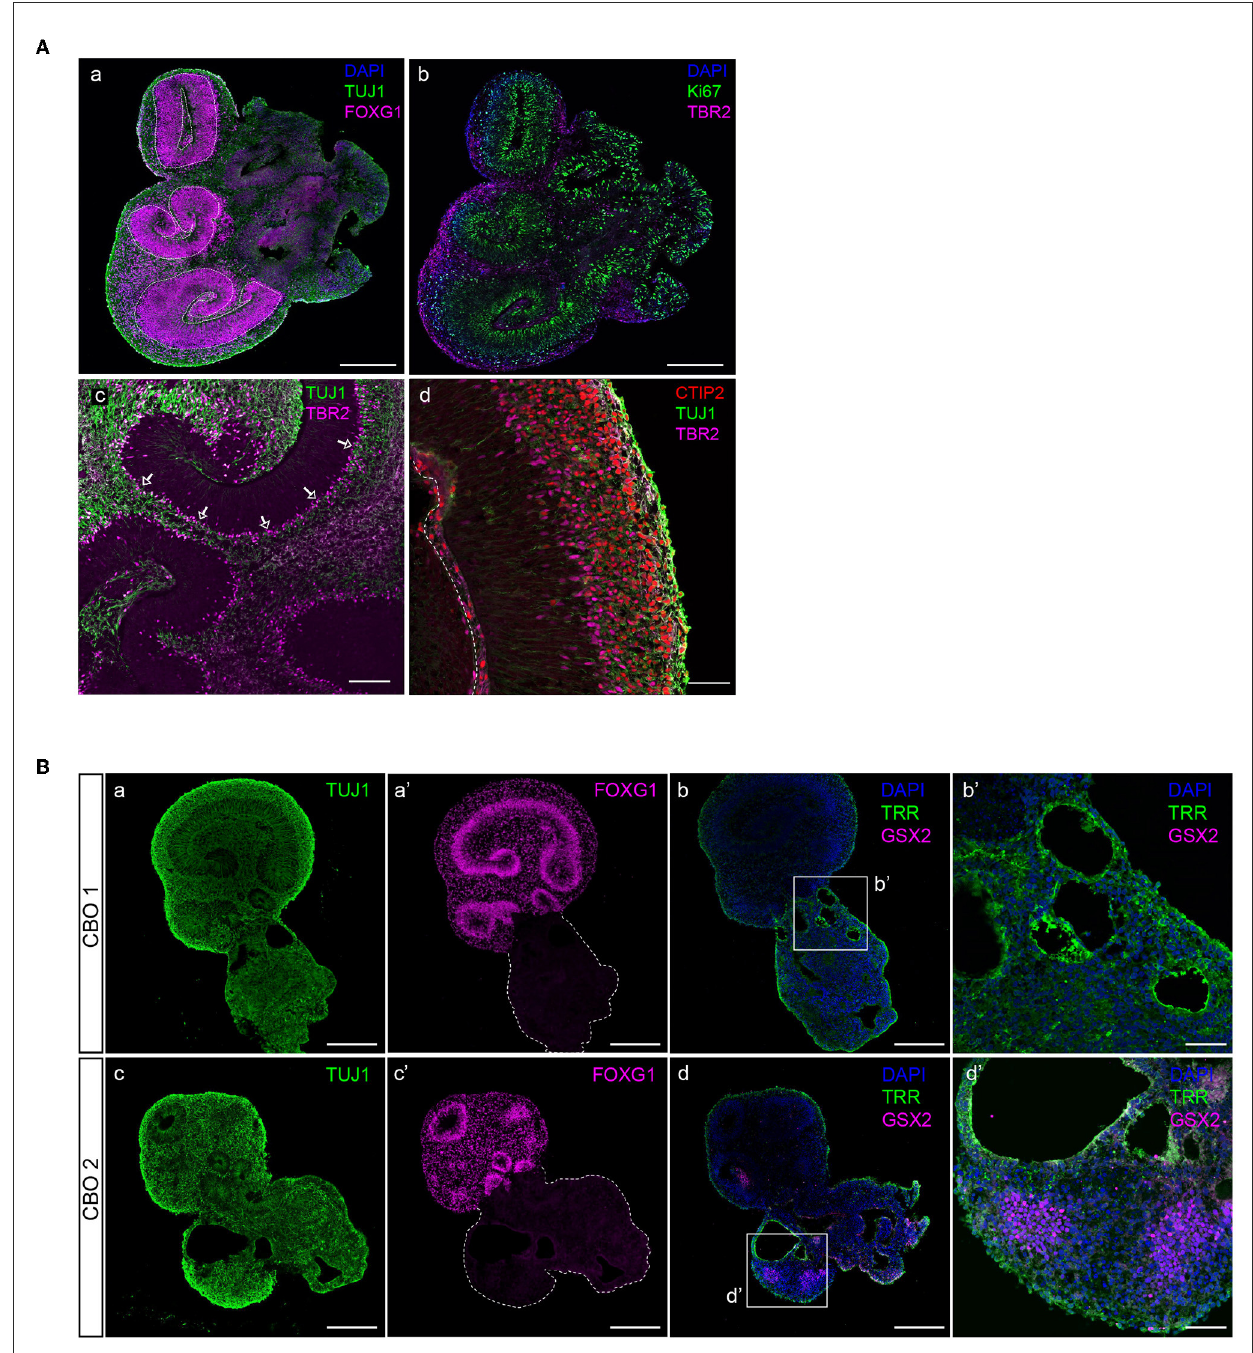
FIGURE5 Characterization of dorsal forebrain identity in cortical organoid brain regions. (A) A 35-day-old organoid showing multiple radial glial progenitor regions (indicated by dashed lines) marked by FOXG1-positive neural progenitor cells, and early neuronal differentiation (TUJ1) (panel a), proliferative progenitors (Ki-67, panel b), and IPCs (TBR2, panel b). Intermediate progenitor cells (TBR2) are generated in the proliferative zone and migrate to align at the basal side (indicated by arrows), where they generate neurons (TUJ1) (panel c). Magnification of a typically organized proliferative zone (TUJ1 negative) located next to a ventricle-like cavity with intermediate progenitors (TBR2) that give rise to deep-layer neurons (CTIP2) that form a layer right above (panel d). Scalebar a, b: 300 µ m, c: 100 µ m, d: 50 µ m. (B) Non-dorsal forebrain identity regions can be recognized by aberrant TUJ1 morphology, lacking progenitor zones (panels a, c), or FOXG1 expression (panels a ′ and c ′ ). The presence of ventral forebrain progenitors (GSX2) and choroid plexus epithelia (TRR) surrounding ventricle-like cavities can be identified (panels b, b ′ , d, and d ′ ). CBO, cortical brain organoid. Scalebar a, a ′ , b, c, c ′ , and d: 250 µ m, b ′ and d ′ : 50 µ